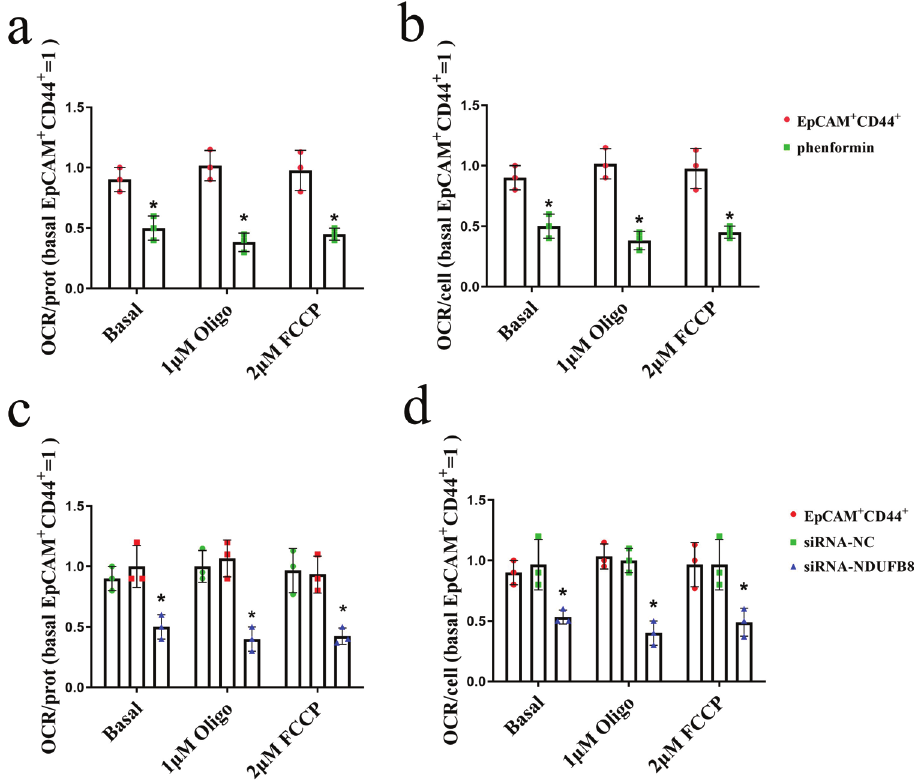
Fig. 3. OCR of EpCAM + CD44 + cells treated with phenformin or siRNA-NDUFB8. OCR of EpCAM + CD44 + cells treated with phenformin (0.5 mM) or not, as assessed by Seahorse Mito stress test (a) or oxygraph (b) analysis. OCR of EpCAM + CD44 + cells treated with siRNA-NDFUB8 or not, as assessed by Seahorse Mito stress test (c) or oxygraph (d) analysis. Results are expressed as mean ± SD ( n = 3). * P < 0.05 versus